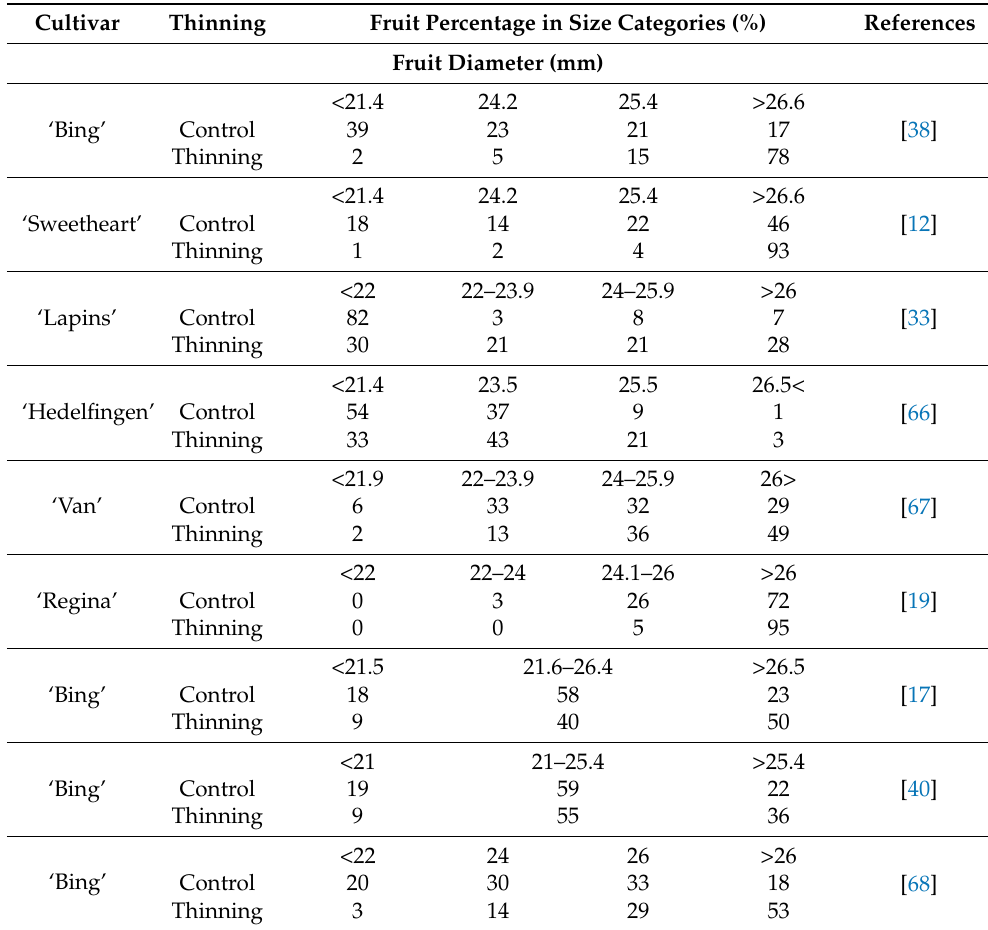
Table 2. Influence of thinning on the distribution of cherry fruit diameter. Cultivar Thinning Fruit Percentage in Size Categories